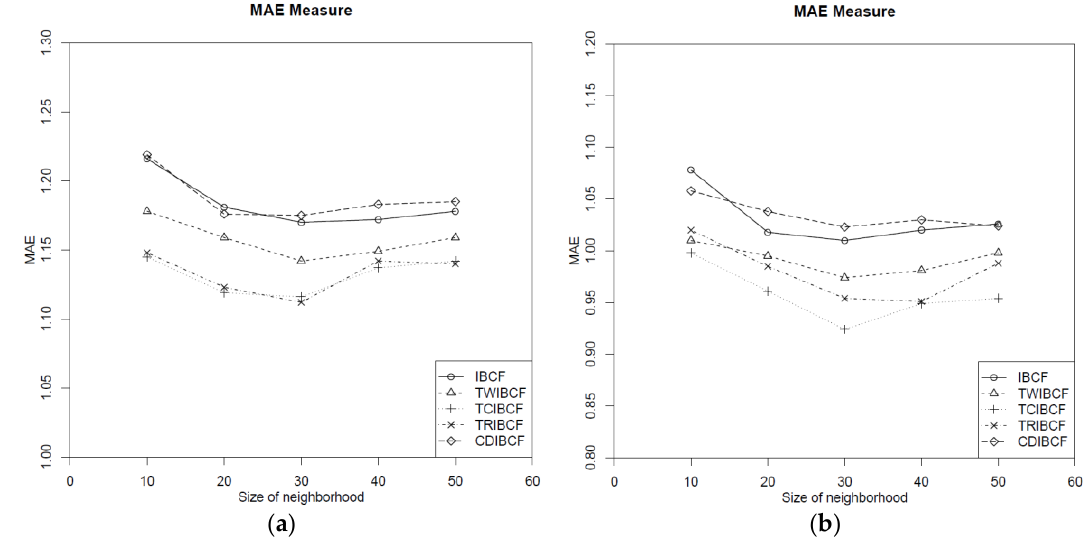
Figure 5. MAE results with MovieLens dataset ( a ) and Netflix dataset ( b ).